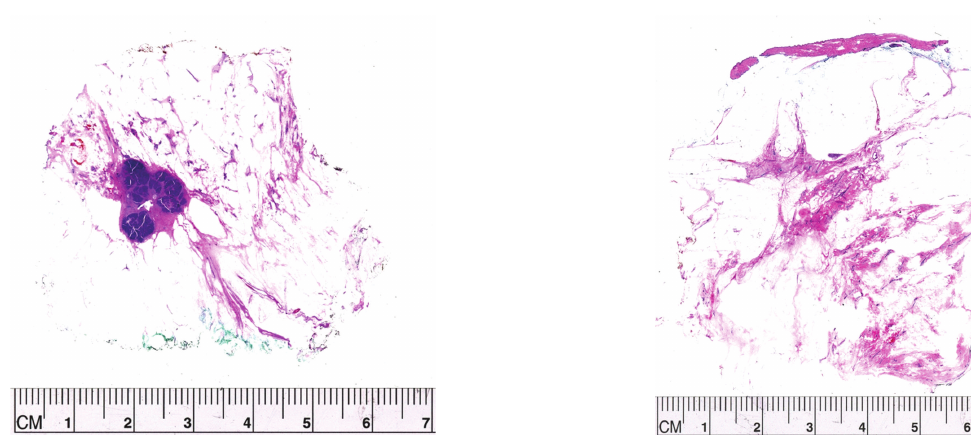
Figure 3: An example of “concentric regression” of tumor after neoadjuvant chemotherapy. She started with a 3cm high grade (9/9 MBRS) invasive ductal carcinoma. At the end of treatment the tumor measured 1.4cm.